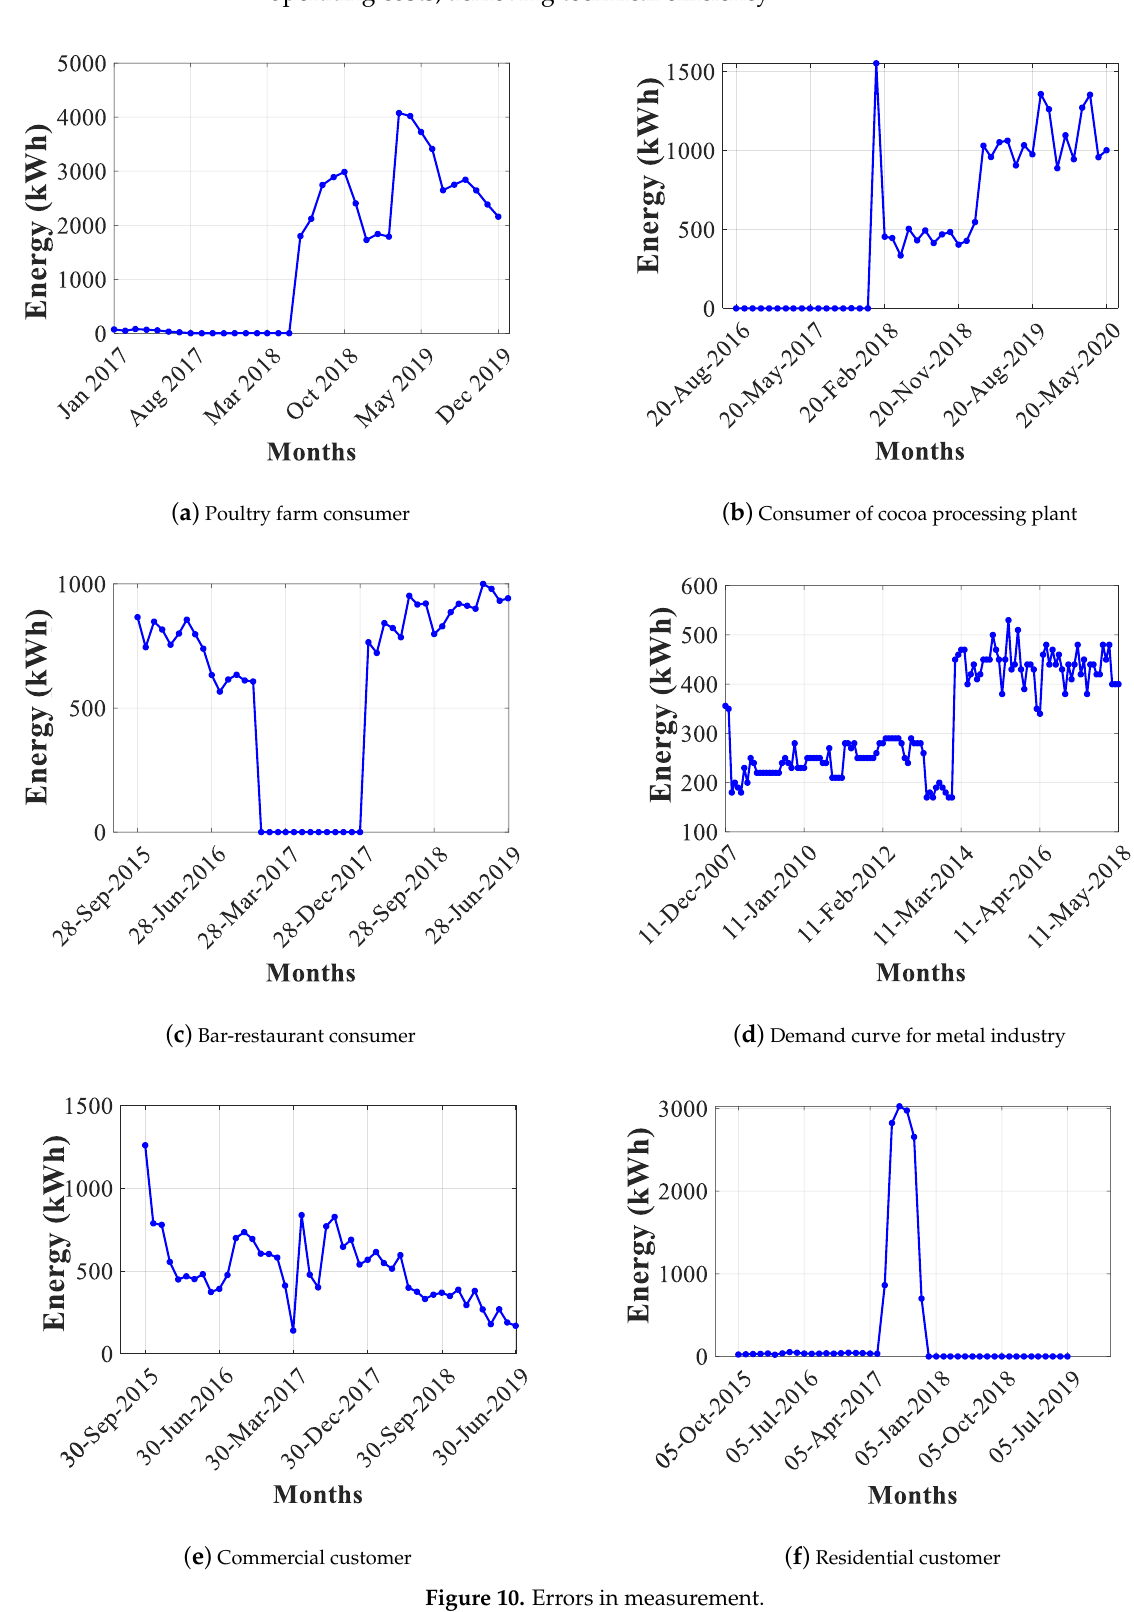
Figure 10. Errors in